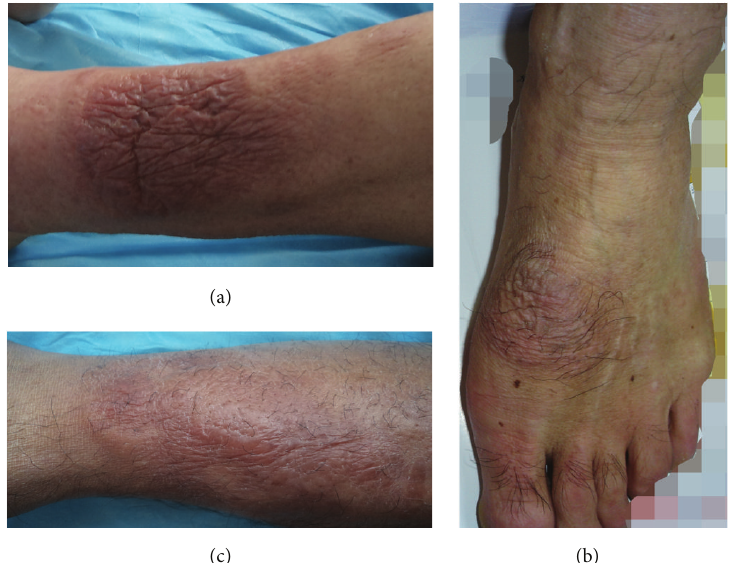
Figure 10: Receding stage. (a) The erythematous, flat lesion with shrinking wrinkles at receding stage on the leg. (b) The well-circumscribed, erythematous, and flat lesion with shrinking wrinkles and hypertrichosis at receding stage on the dorsum of a foot. (c) The ill-defined, erythematous lesion with shrinking wrinkles and tense swelling plaques at receding stage on the